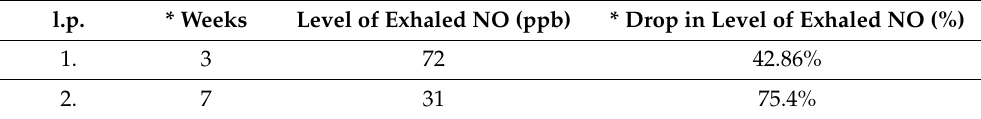
Table 1. Change in the value of NO concentration in the exhaled air.